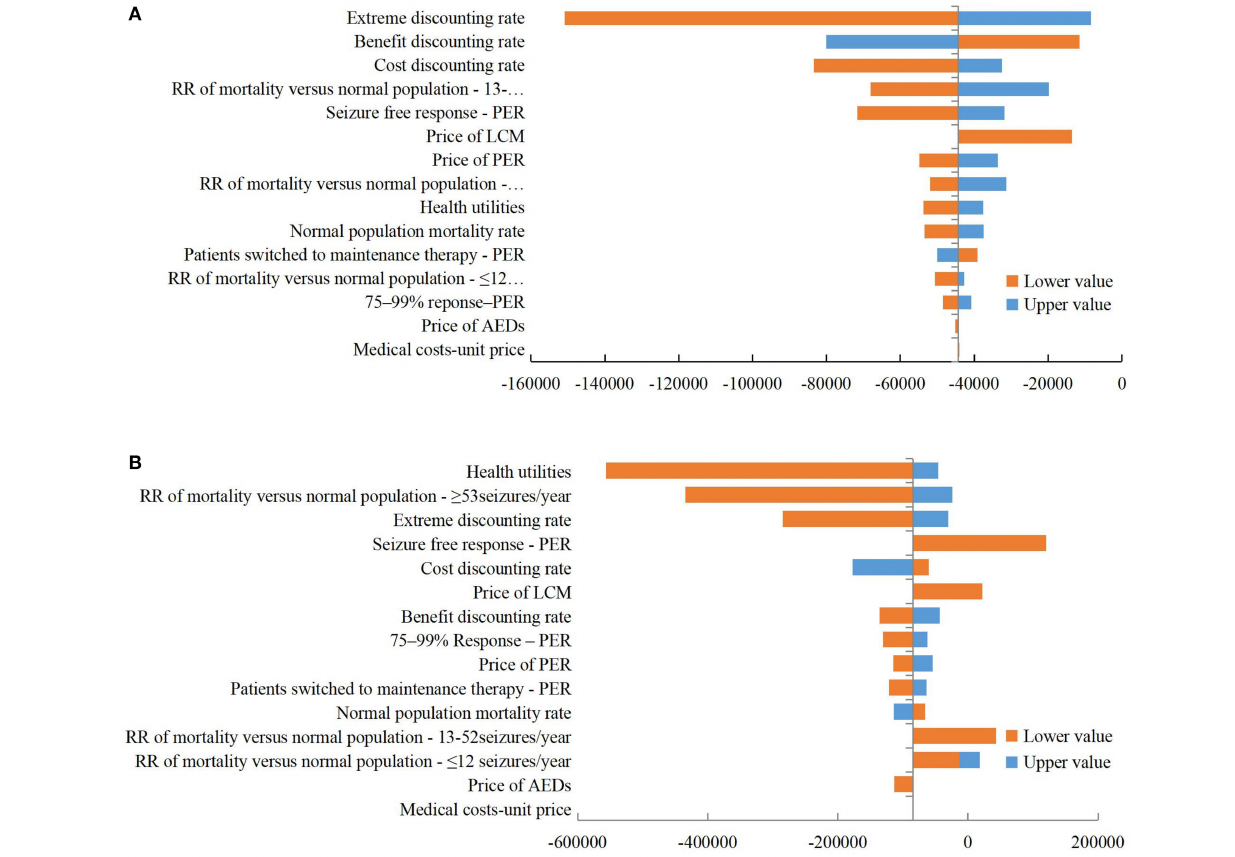
saving of $2,390. Compared with LCM200 mg/day, PER 4